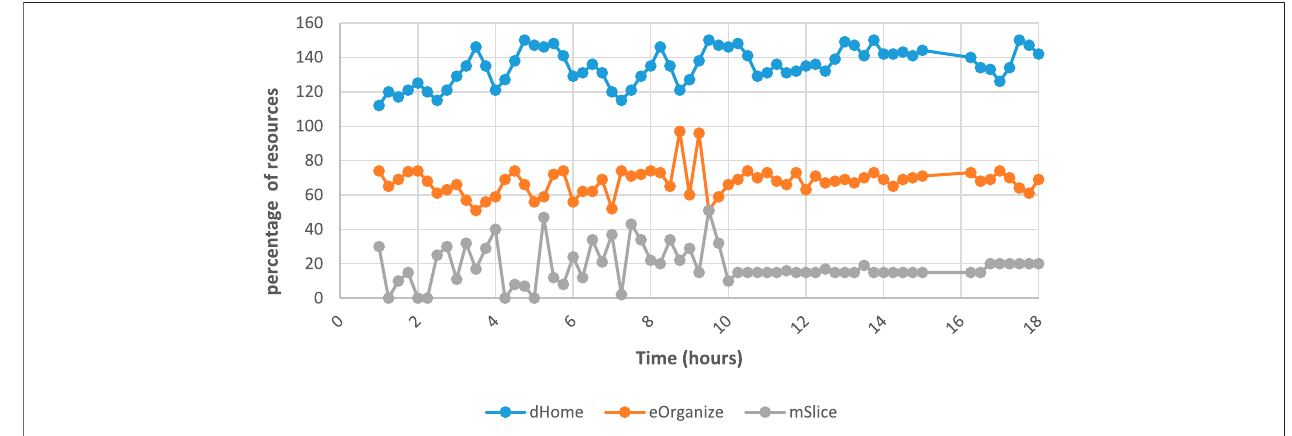
FIGURE 5 | Automatic allocation of mSlice to eOrgnaize requests after overloading conditions.